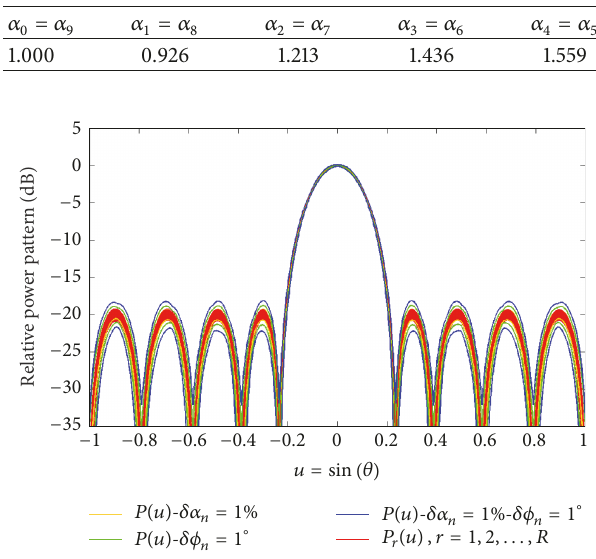
Figure 1: Bounds of the power pattern 𝑃(𝑢) based on IA with 𝛿𝛼 𝑛 = 1 %, 𝛿𝜑 = 1 ∘ . 𝑛